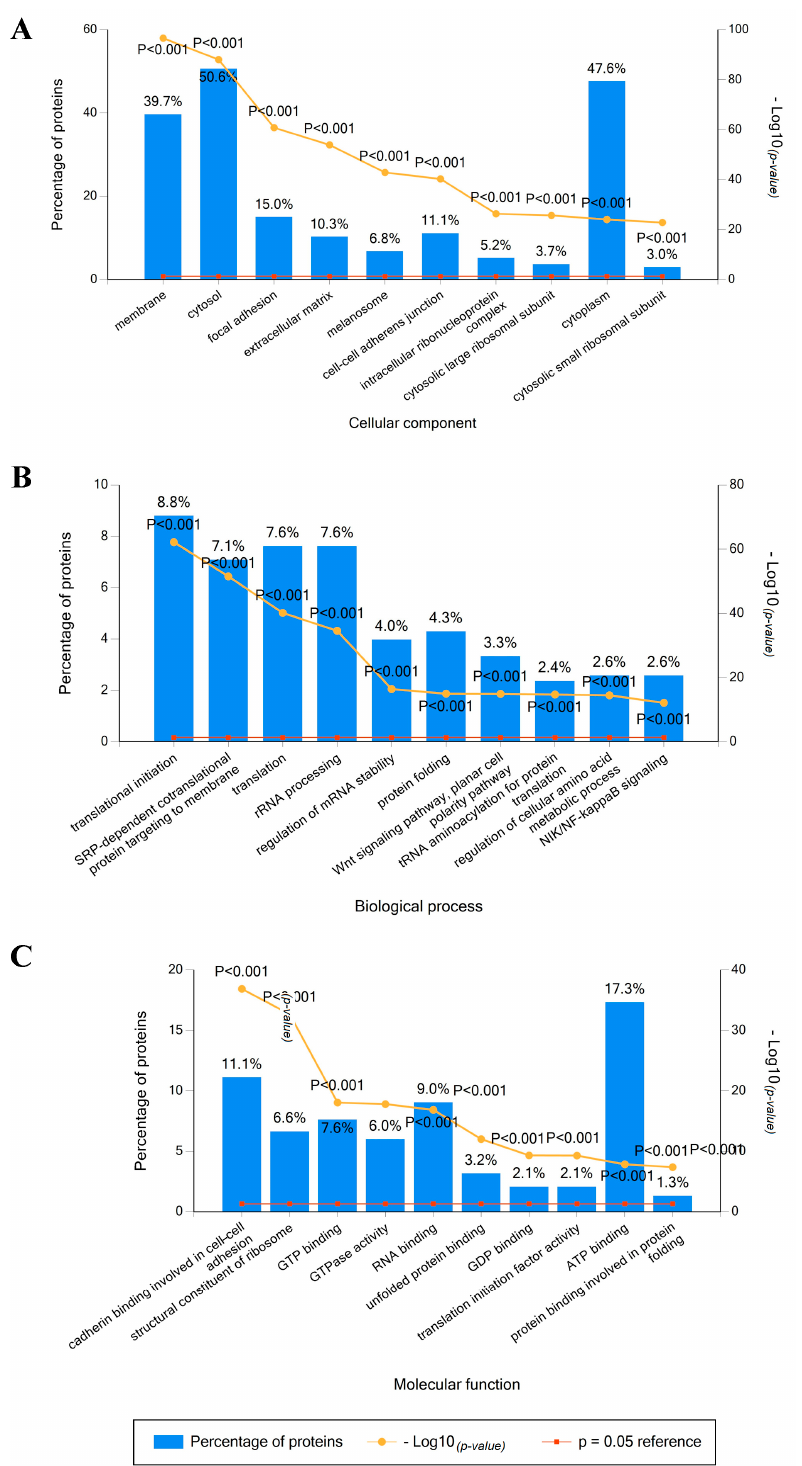
Figure 2. Gene ontology analysis of Mel202-derived ectosomal proteins using the UniProt protein database. Proteins were grouped according to the cellular compartments of their origin ( A ), involvement in different biological processes ( B ), and molecular functions ( C ). In each case, the ten most abundant groups (according to the percentage of assigned proteins) were presented on each graph. The p -value depicts the statistical significance of protein enrichment within the given categories.